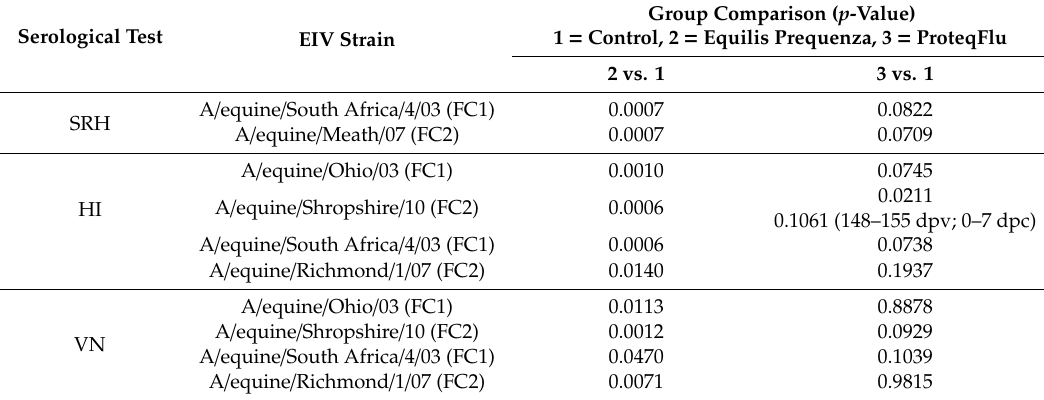
Table 2. Results of inferential statistics: comparison of post-challenge seroconversion between groups (slope of 148–162 dpv, 0–14 dpc).